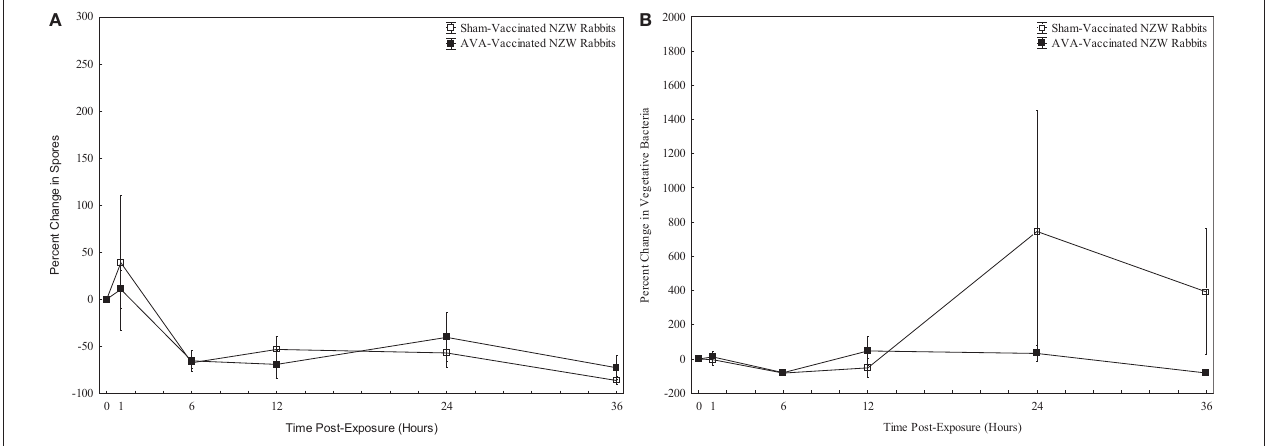
FIGURE 2 | Percent change in (A) spores and (B) vegetative bacteria in homogenized lung tissue from sham-vaccinated ( (cid:2) ) and AVA-vaccinated ( (cid:3) ) rabbits. Data were obtained immediately following exposure (1h) and at 6, 12, 24, and 36h post-exposure. All data are expressed as a percent change